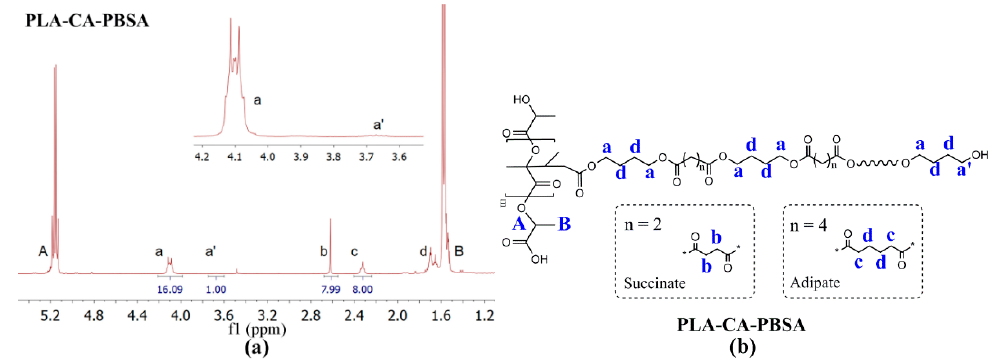
Figure 1. ( a ) 1 H NMR spectrum of PLA-CA-PBSA; ( b ) The peak assignment for the structure.